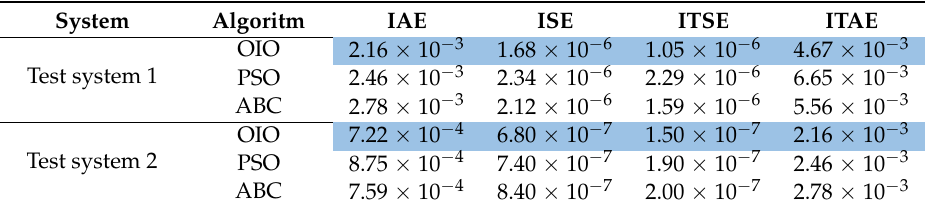
Table 5. Value of cost function for OIO, PSO, and ABC.